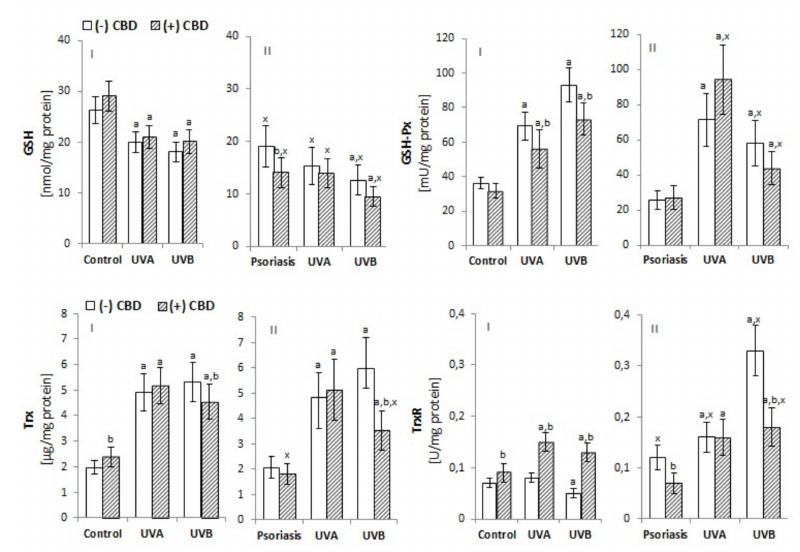
Figure 2. E ff ect of CBD (4 µ M) on reduced glutathione (GSH) level (A-I and A-II) and glutathione peroxidase (GSH-Px) activity as well as thioredoxin (Trx) level and thioredoxin reductase (Trx-R) activity in keratinocytes exposed to UVA (30 J / cm 2 ) and UVB (60 mJ / cm 2 ) radiation. Keratinocytes were obtained from healthy subjects ( I ) (n = 15) and patients with psoriasis vulgaris ( II ) (n = 30). The mean values ± SD are presented with statistically significant di ff erences: a -vs. control / psoriasis group; b -vs. group without CBD; x -psoriasis vs. control groups; p < 0.05.